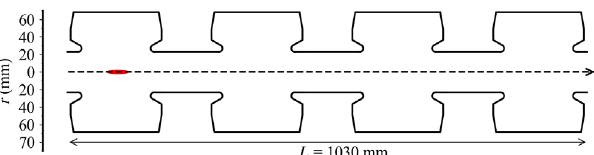
FIG. 7. Four-cavity structure. Each cavity is identical to the one in Fig. 1 and the center-to-center spacing is 314.3